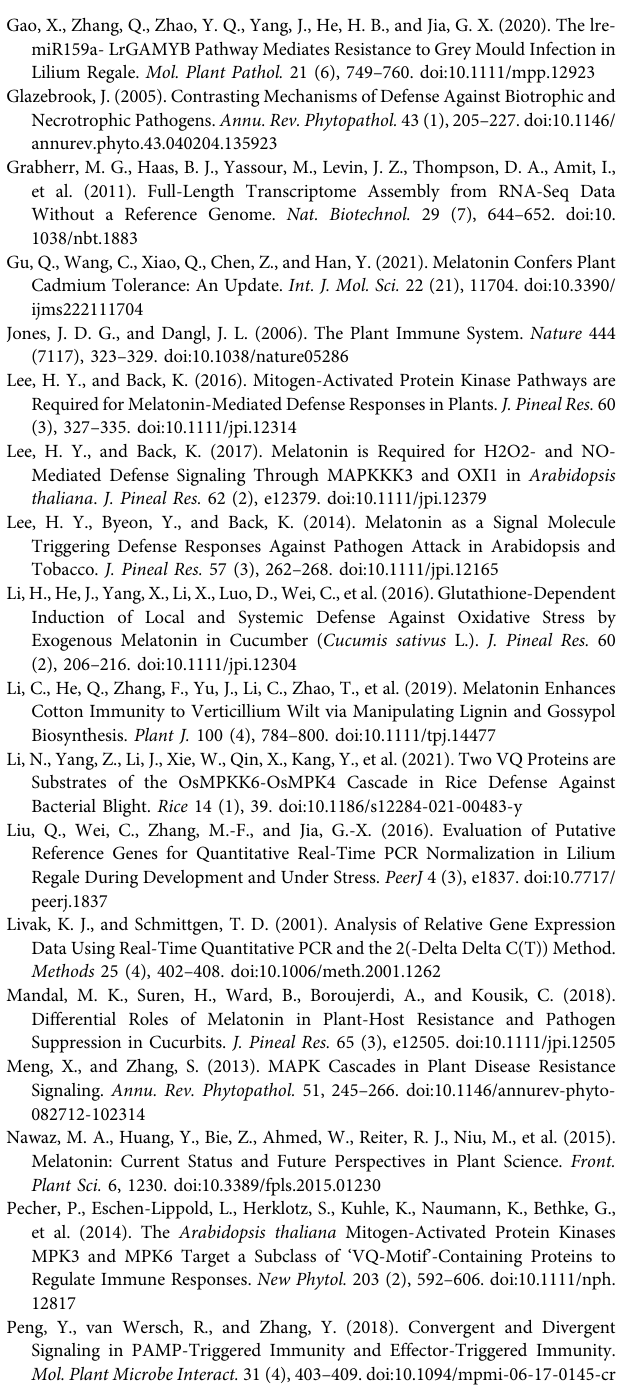
Supplementary Table S1 | Quality statistics for transcriptome sequencing (RNA- seq) data. Supplementary Table S2 | The summary statistics of the assembled transcripts and unigenes. Supplementary Table S3 | The success rate of functional annotation in transcriptome unigenes.